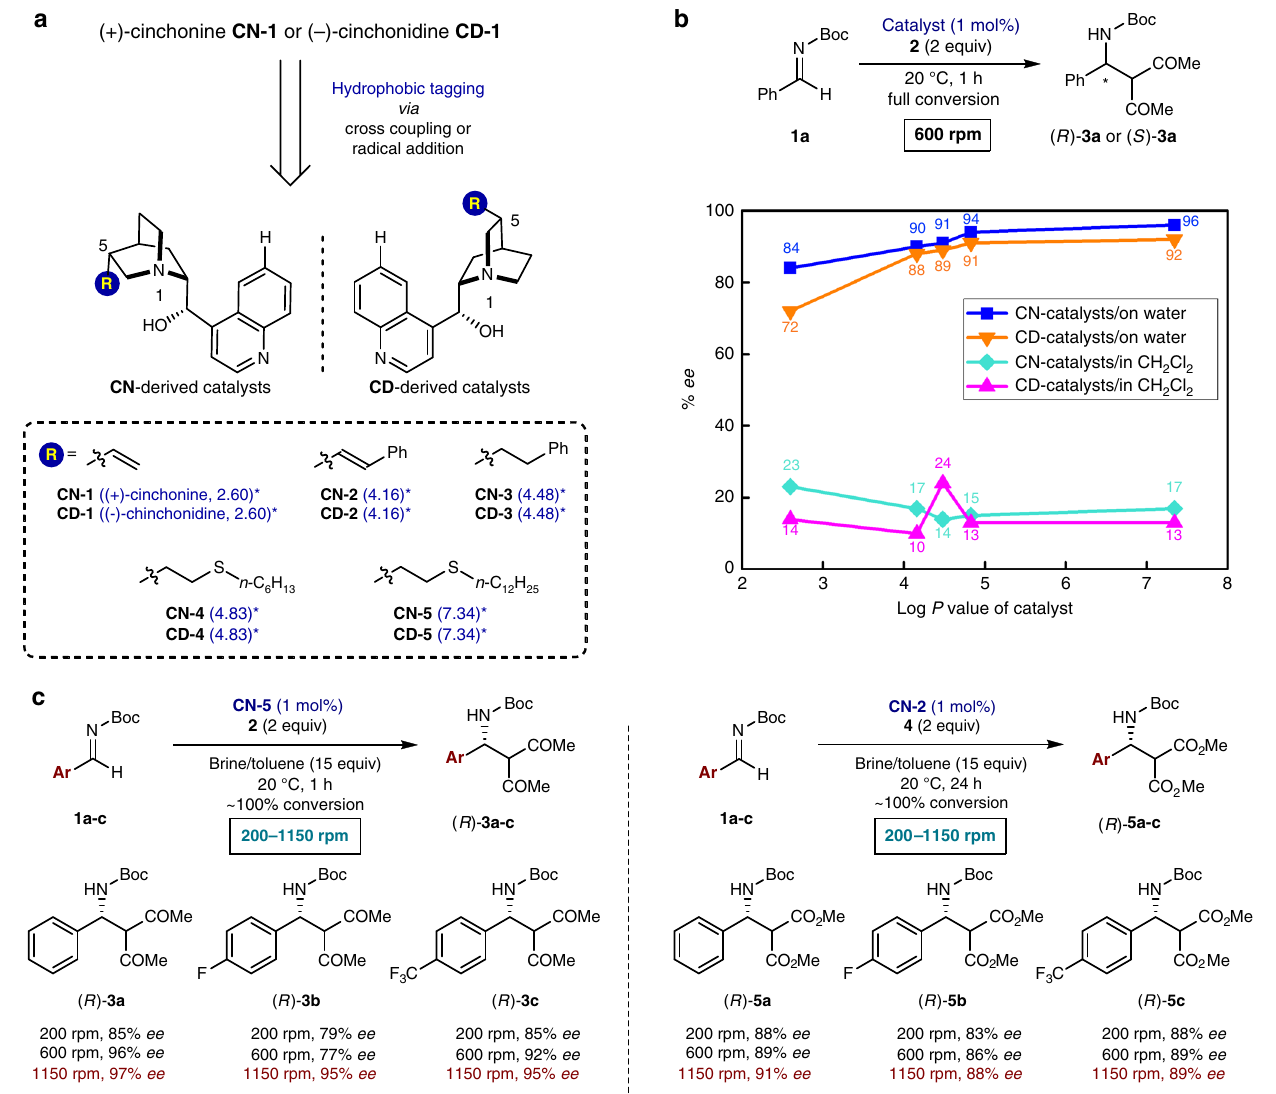
Fig. 2 Enantioselectivity of the Mannich product depending on catalyst hydrophobicity and stirring rate. a Chiral catalysts used in this study. b Effect of catalyst hydrophobicity on enantioselectivity. Conditions: 1a (0.3 mmol), 2 (0.6 mmol), catalyst (1 mol%), and brine (2.0 mL)/toluene (15 equiv) or CH 2 Cl 2 (2.0 mL). c Effect of stirring speed on enantioselectivity. Conditions: 1a – 1c (0.3 mmol), 2 or 4 (0.6 mmol), catalyst (1 mol%), and brine (2.0 mL)/toluene (15 equiv). For experimental details regarding controlling the stirring speed, see the Supplementary Figure 1. Enantiomeric excess (% ee ) was determined by high-performance liquid chromatography (HPLC). *The Log P values (the P value is a n -octanol/water partition coef fi cient) of catalysts were calculated using ChemBioDraw Ultra 12.0 of brine and organic solutions containing the organic reactants Table 3). As the size of the droplet decreased, the ee values and catalyst CN-2 or CD-2 . The reaction mixture was injected increased. When using the same tube, the ee values of the product into the system using a syringe pump, collected at the outlet of increased when the Q w /Q o increased. Under the same brine – organic fl ow ratios (Q w /Q o ), the smaller size of the inner the fl uorinated ethylene propylene (FEP) tubing (inner diameter ( ø ) = 250, 500, and 1000 μ m, length = 15 m) (Fig. 3a). A series of droplets with different sizes was formed in the FEP tubing by adjusting the fl ow rate ratio (Q w /Q o ) between the aqueous and organic phases (Fig. 3b). After the tube was fi lled with the reaction mixture, the fl ows of brine and organic solutions were stopped, and the outlet of the tube was then sealed with a plastic paraf fi n fi lm. The other end of the tube was also sealed with a plastic paraf fi n fi lm. The static biphasic plugs were then kept inside the FEP tubing for 48 h at 20 o C. Without any stirring, the reaction proceeded smoothly even in the static droplets.